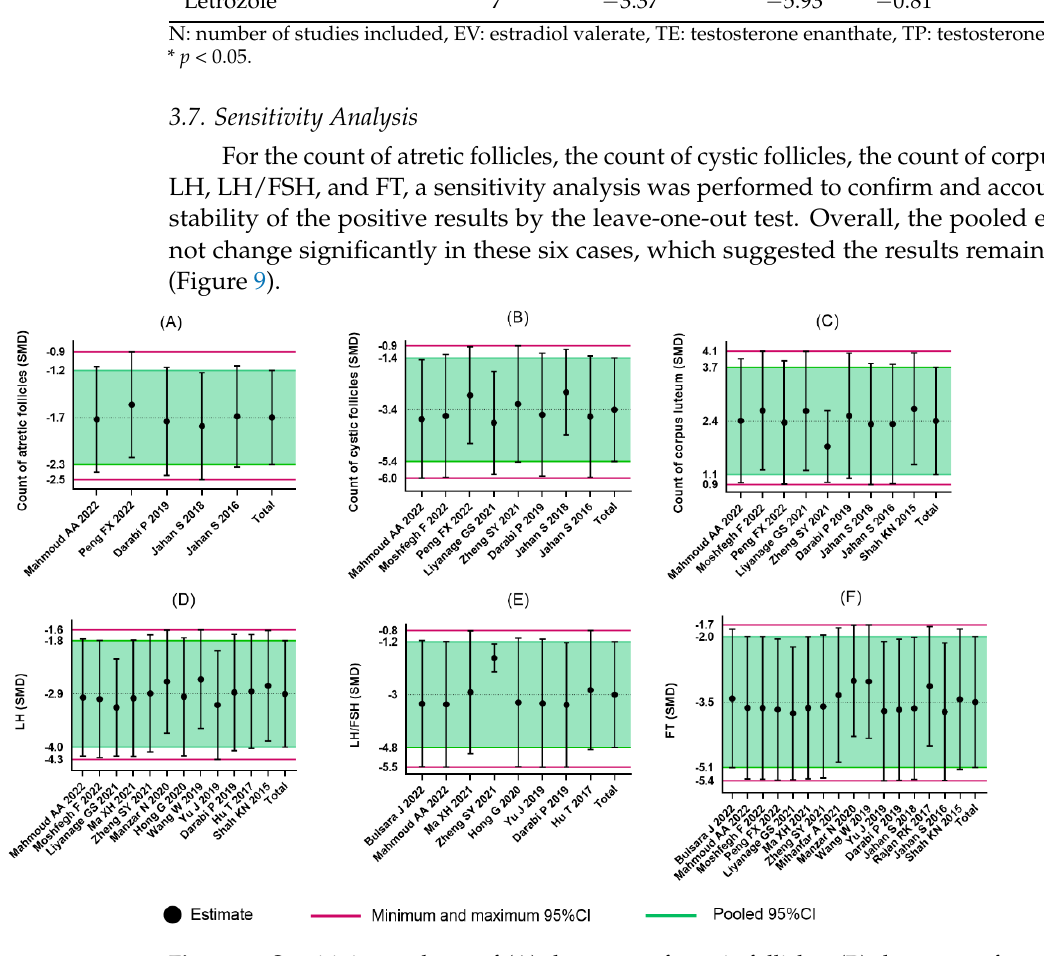
Figure 9. Sensitivity analyses of ( A ) the count of atretic follicles, ( B ) the count of cystic follicles, ( C ) the count of corpus luteum, ( D ) LH, ( E ) LH/FSH, and ( F ) FT.